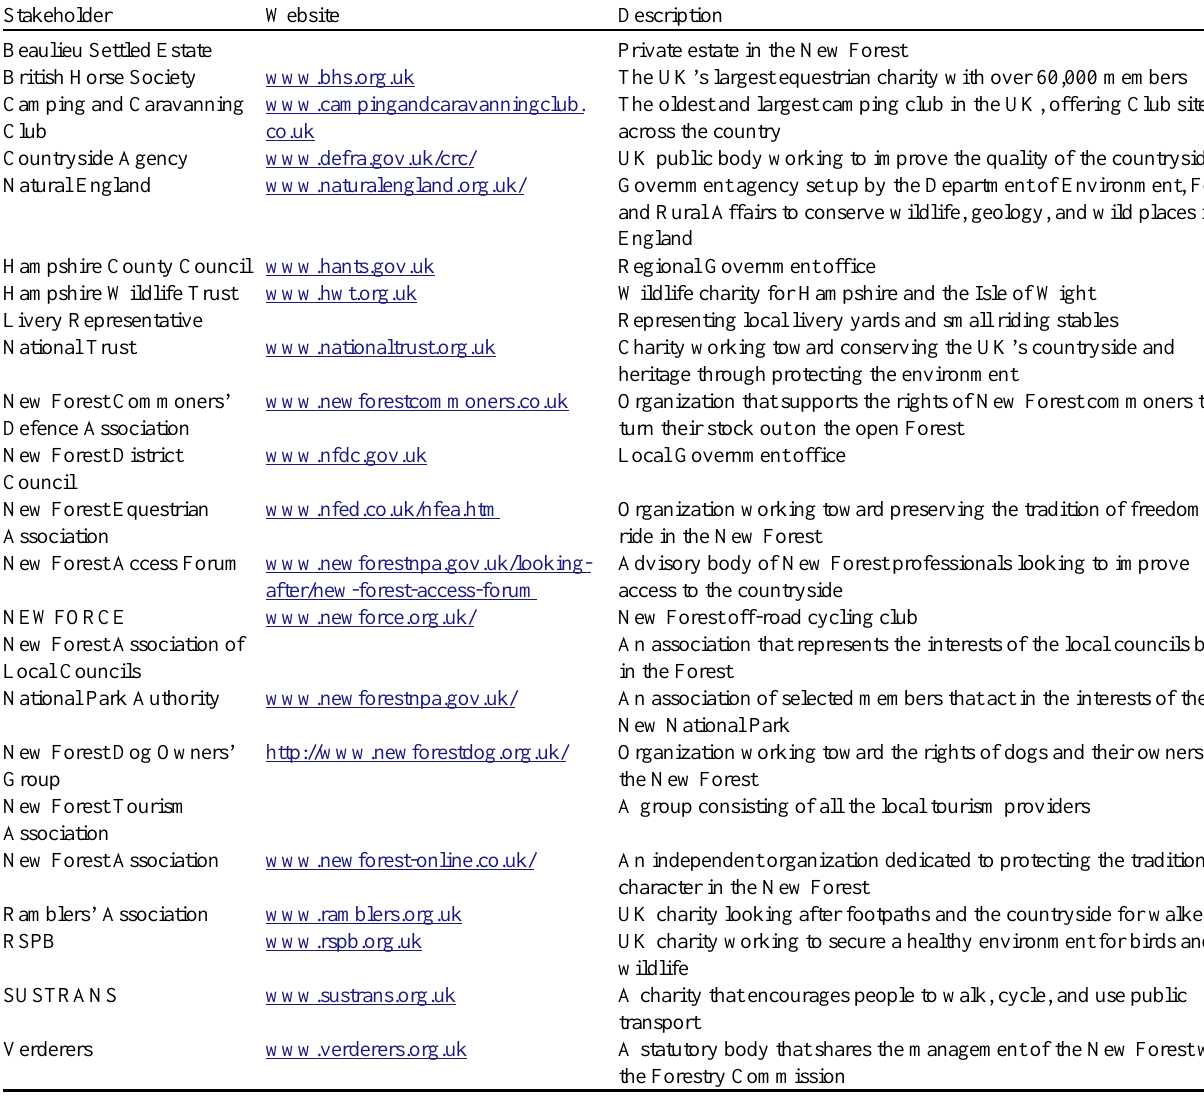
Table 1. Stakeholders involved in the PROGRESS project in alphabetic order. Together with the Forestry Commission they discussed the management alternatives and made decisions about the pilot